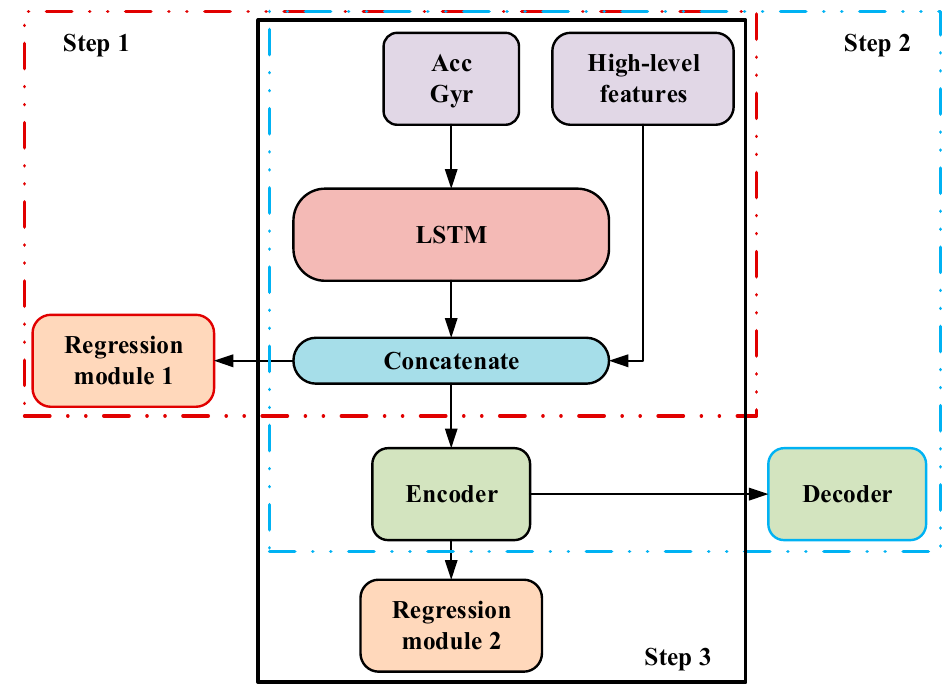
Figure 6. The proposed training frame.